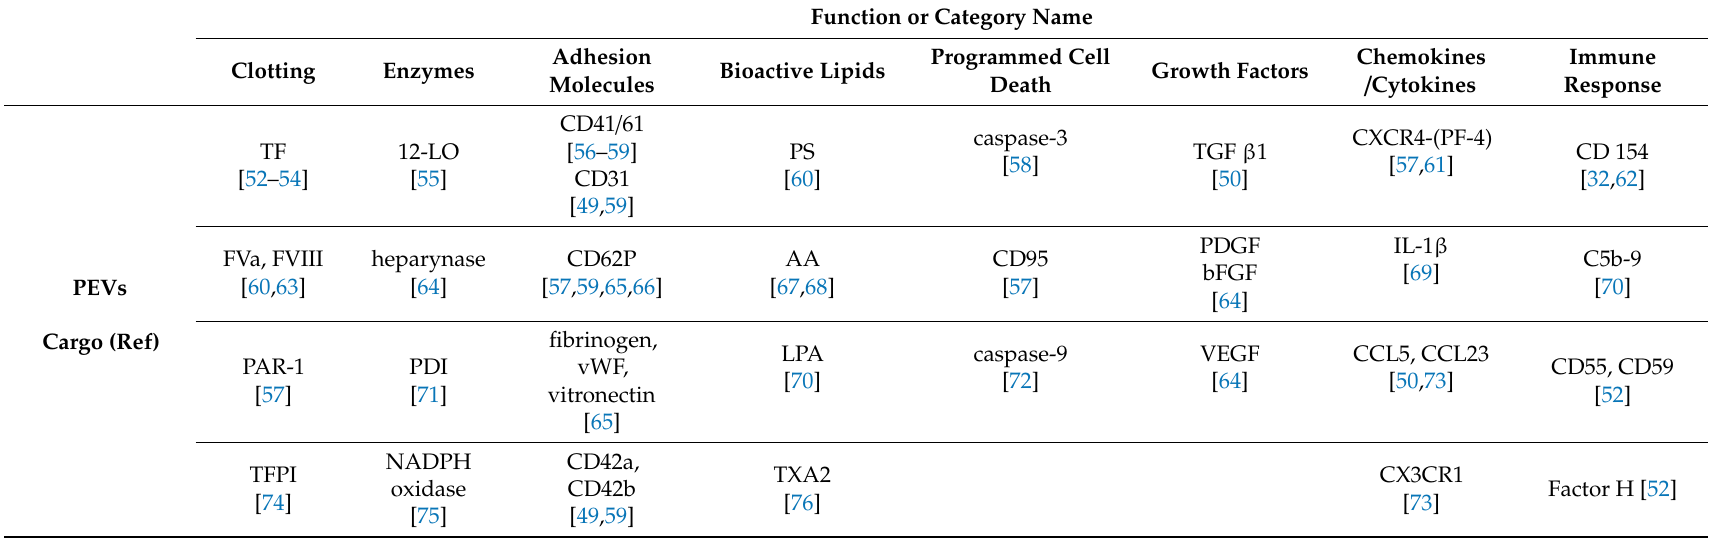
Table 1. Comparison of the PEVs cargo and their function. Biologically active molecules, receptors, enzymes, chemokines were categorized based on their functions of the PEVs, but there are no discrepancies detailed for some